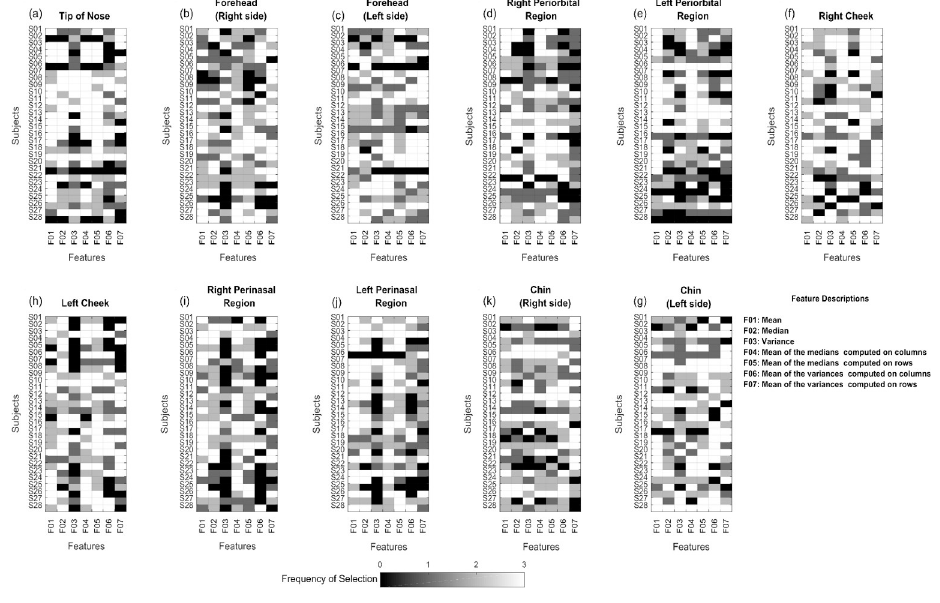
Fig 3. Feature selection maps for each